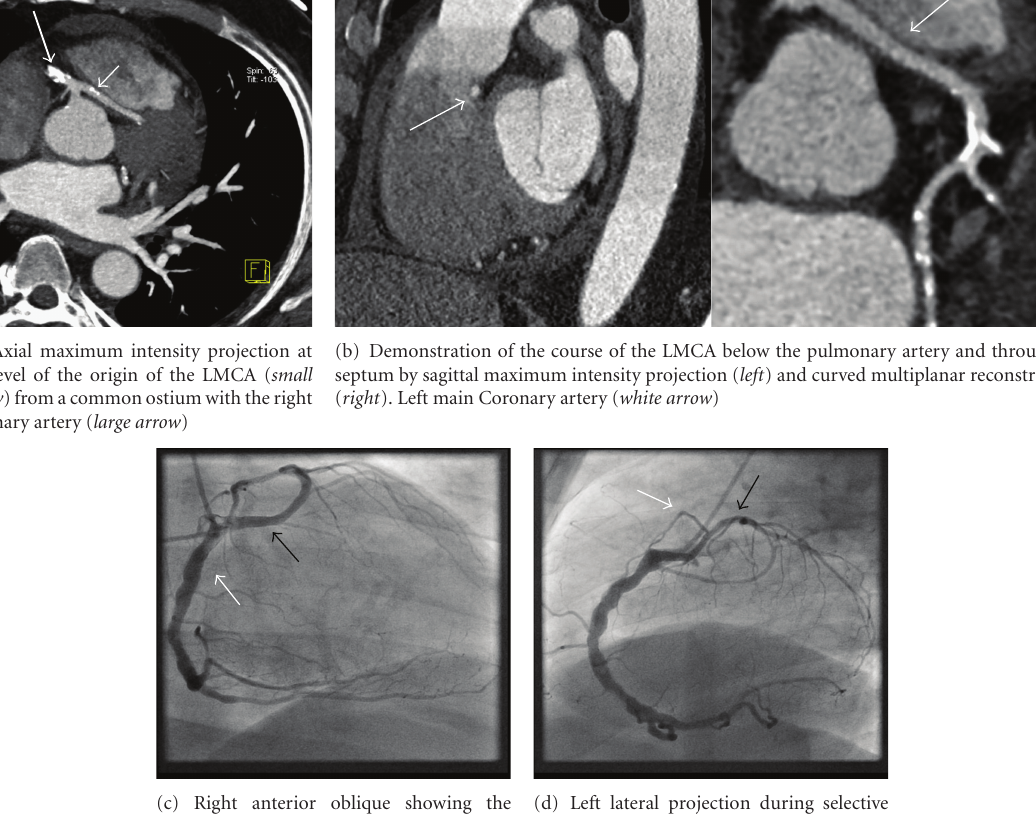
direction during suspended respiration at 0.75 mm